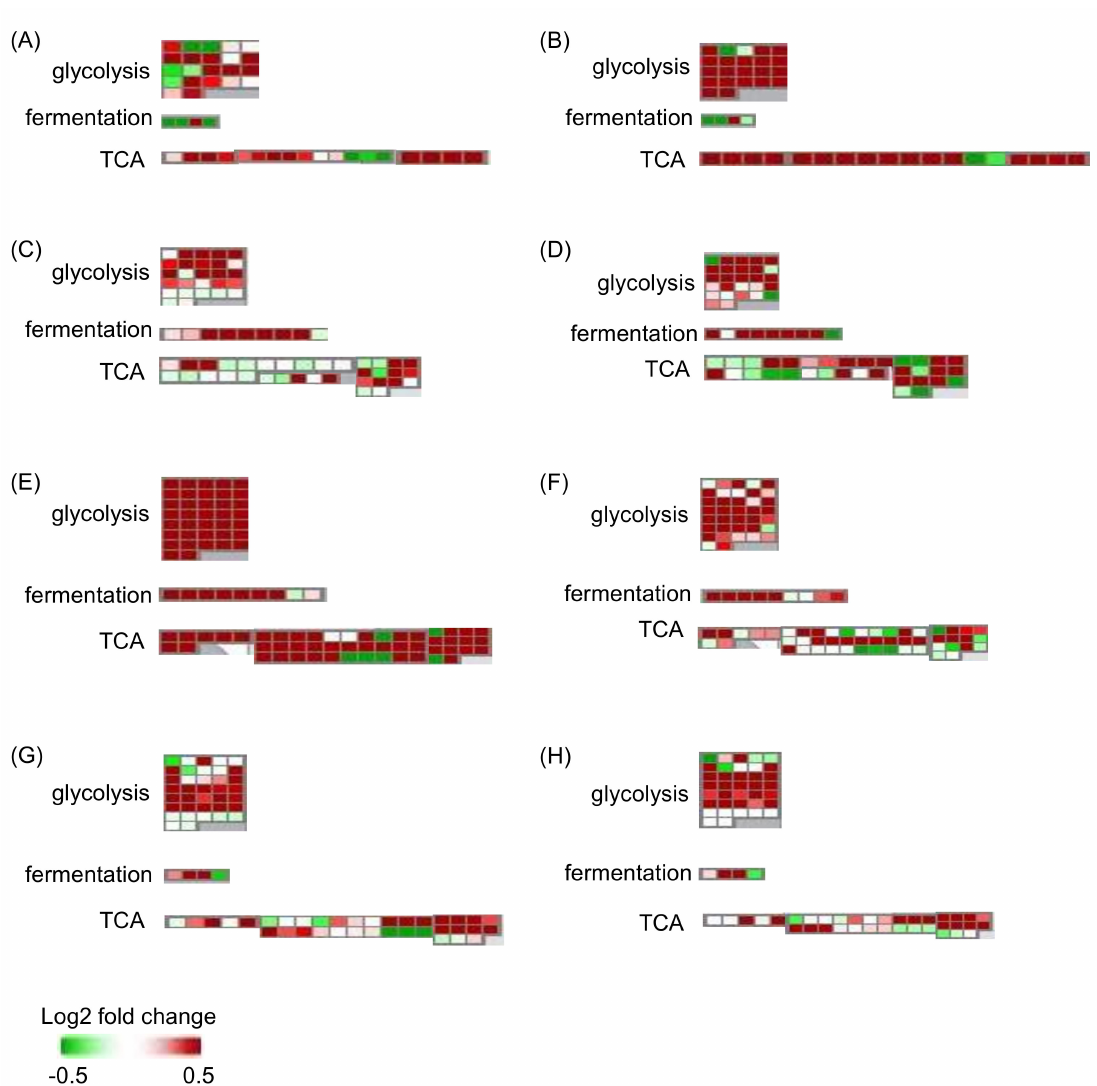
Figure 2. Abundance of proteins mapped to glycolysis, fermentation, and tricarboxylic acid cycle in soybean plants. ( A ) Four-day-old wild-type soybean without flooding stress. ( B ) Six-day-old wild-type soybean without flooding stress. ( C ) Four-day-old wild-type soybean flooded for two days. ( D ) Six-day-old wild-type soybean flooded for four days. ( E ) Four-day-old wild-type soybean flooded for two days coupled with ABA treatment. ( F ) Six-day-old wild-type soybean flooded for four days coupled with ABA treatment. ( G ) Four-day-old flooding-tolerant soybean flooded for two days. ( H ) Six-day-old flooding-tolerant soybean flooded for four days. Two-day-old wild-type soybean plants were treated without or with flooding for two and four days. For ABA treatment, 10 µ M ABA was supplied to wild-type soybean plants exposed to flooding at the same time. Two-day-old flood-tolerant mutant plants were exposed to flooding for two and four days. Unstressed wild-type soybean plants served as control. Green and red colors indicate a decrease and increase, respectively, in fold change values compared with two-day-old unstressed wild-type soybean plants. Abbreviation: TCA, tricarboxylic acid